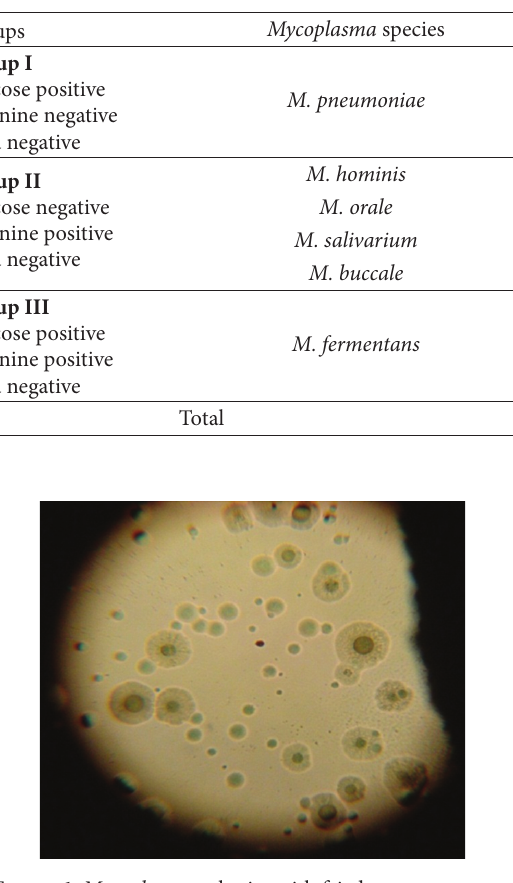
Figure 1: Mycoplasma colonies with fried-egg